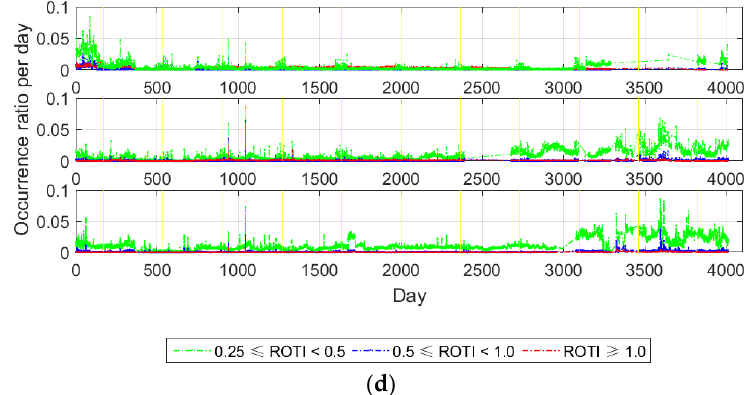
Figure 9. The daily occurrence ratio (by DOY) of the different-level TEC fluctuations at the 21 selected GNSS sites from 2002 to 2012. The green line represents the daily occurrence ratio of weak TEC fluctuations that satisfy 0.25 ≤ ROTI < 0.5; the blue line represents the daily occurrence ratio of moderate TEC fluctuations that satisfy 0.5 ≤ ROTI < 1; and the red line represents the daily occurrence ratio of strong TEC fluctuations that satisfy ROTI ≥ 1. The straight yellow lines denote the day of the summer solstice of each year. The site names of each subfigure are as follows: ( a ) YONG, QION, GUAN, KMIN, XIAM, XIAG; ( b ) LUZH, WUHN, XIAA, ZHNZ, DLHA, TAIN; ( c ) XNIN, BJFS, BJSH, JIXN, WUSH, URUM; ( d ) DXIN, SUIY, HLAR.